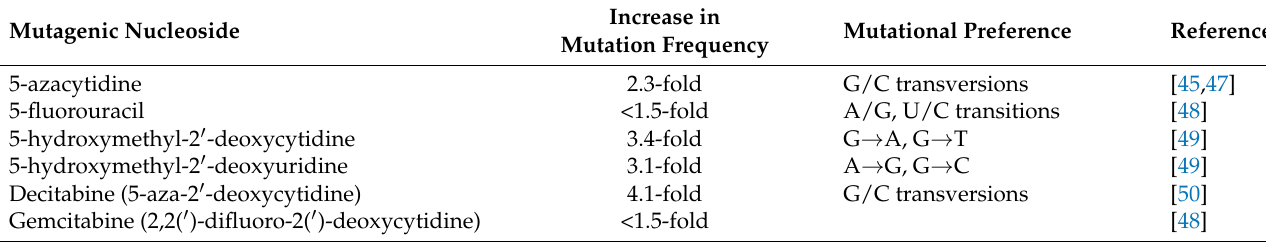
Table 1. Mutagenic nucleosides and their mutational effects on